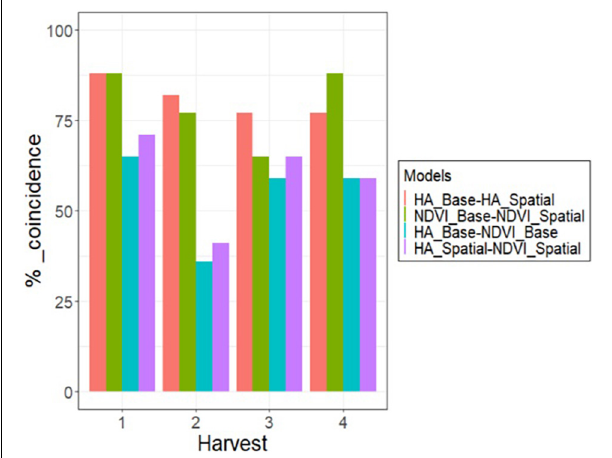
FIGURE 6 | Percent of coincidence in selection for the 10% best alfalfa families between HA and NDVI, using the base and spatial model, across four harvests in alfalfa families evaluated in Citra, FL, United